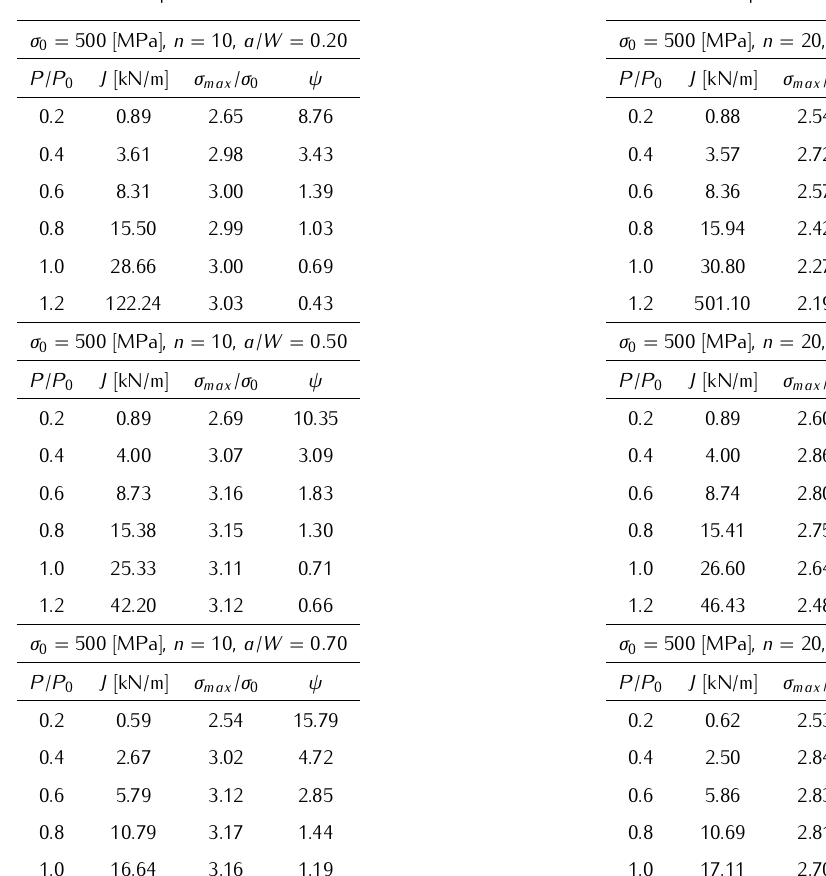
Table B4. Numerical results for CC(T) specimens characterized by yield stress σ MPa and work hardening exponent 0 = 500 in R-O relationship n =